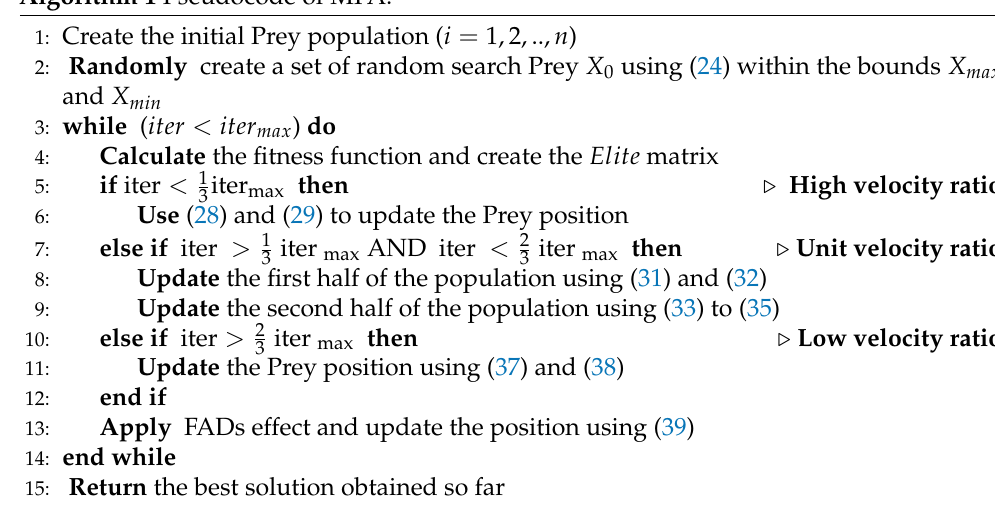
Algorithm 1 Pseudocode of